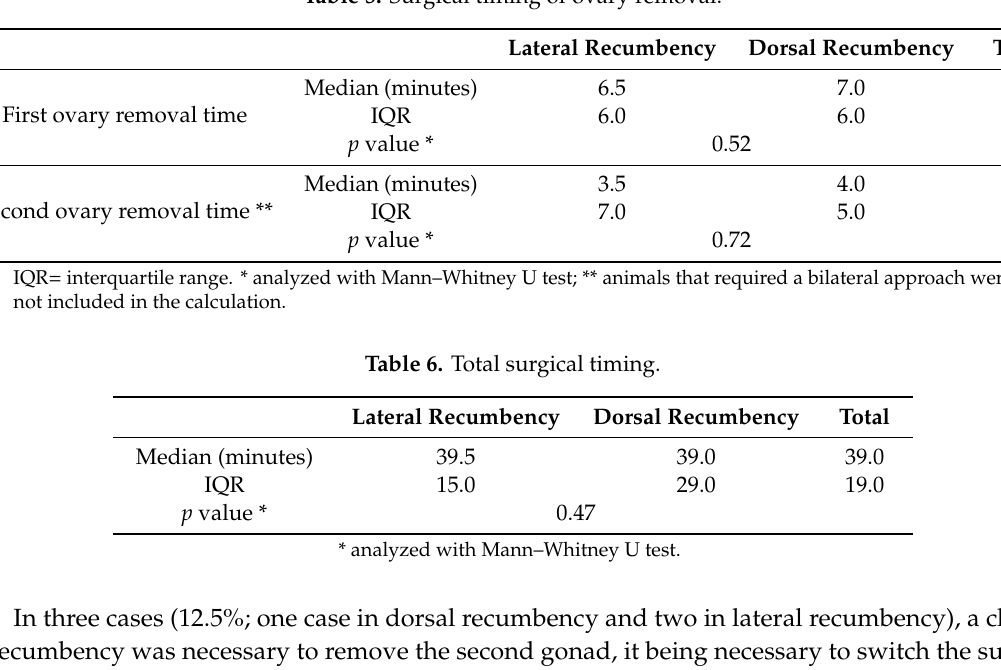
Table 5. Surgical timing of ovary removal.